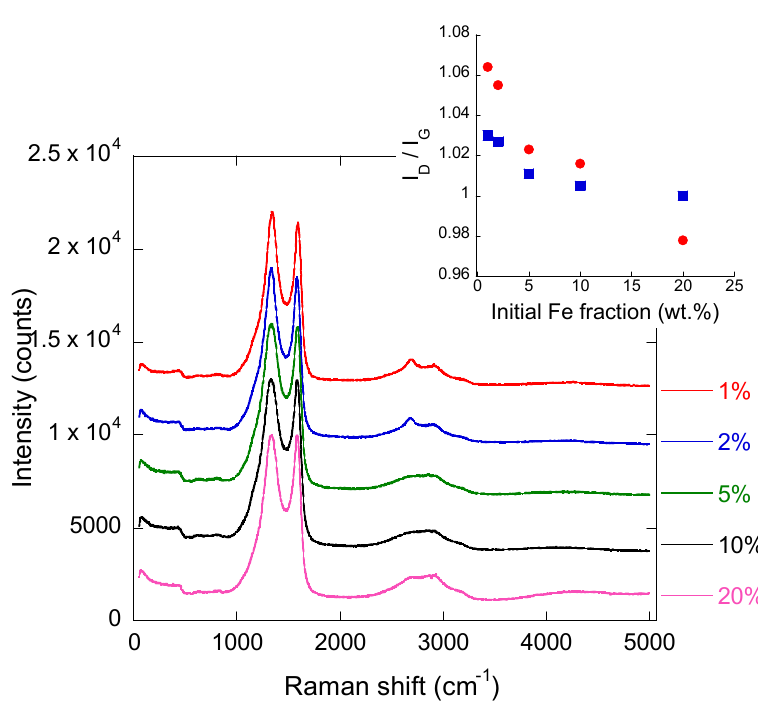
Figure 12. Raman spectra (shifted with respect to each other for clarity) of carbon materials loaded with increasing amounts of Fe (from top to bottom). The inset shows the corresponding changes of D to G band intensity ratio, either calculated after baseline correction and peak deconvolution (red discs) or directly determined from the raw spectra given here (blue